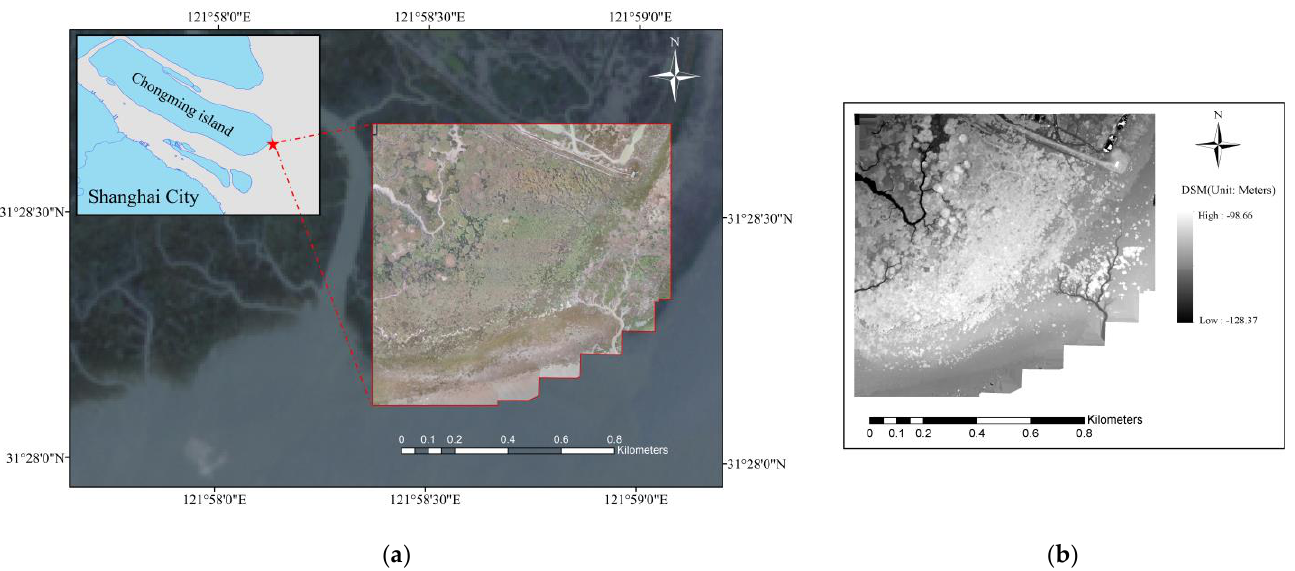
Figure 1. Research area in the Chongming wetlands. ( a ) Location of CDNNR, Shanghai, China, and UAV-based RGB Orthomosaic in the study area marked by the red line; ( b ) DSM data derived from the RGB Orthomosaic.